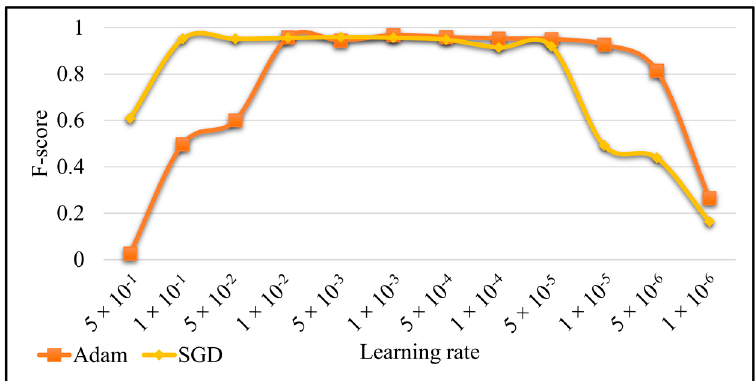
Figure 6. Obtained F-score values for two ANN architectures using the Adam and SGD learning algorithms based on different learning rate values.